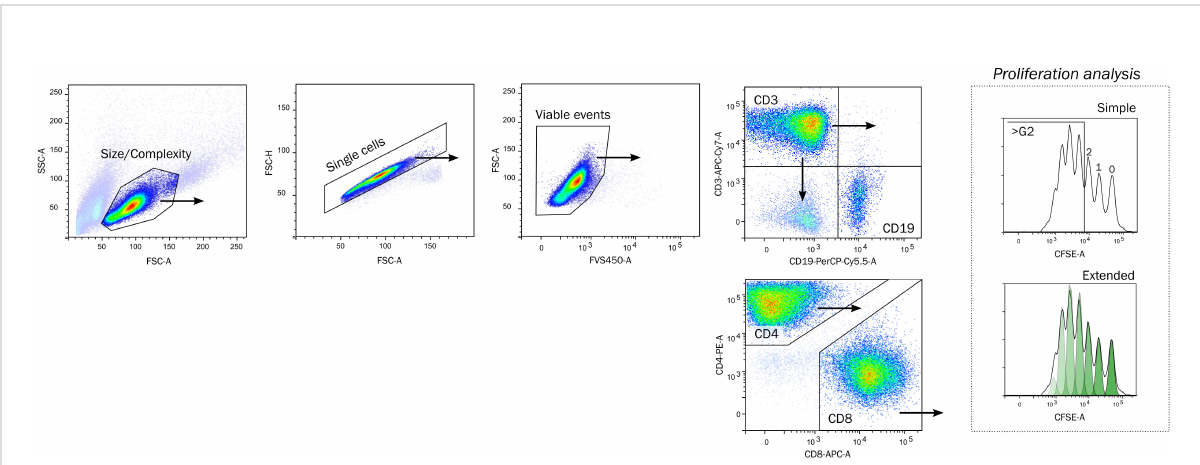
FIGURE 1 Gating strategy. Lymphocytes were identi fi ed by a crude Size and Complexity gate, Single cells by area/height proportionality on forward scatter pulse, and viable as FVS450-negative. The proliferation of lymphocytes was quanti fi ed on CD3+ CD19- T cells by a simple or extended proliferation analysis. The simple strategy enumerates cells having divided beyond the second generation, whereas the extended analysis fi ts a model to calculate metrics (see methods for details). The CD3+ cells were further divided into CD4+ and CD8+ cells. FSC-A/FSC-H, forward scatter area/height, FVS450, fi xable viability stain 450; CFSE, Carboxy fl uorescein succinimyl